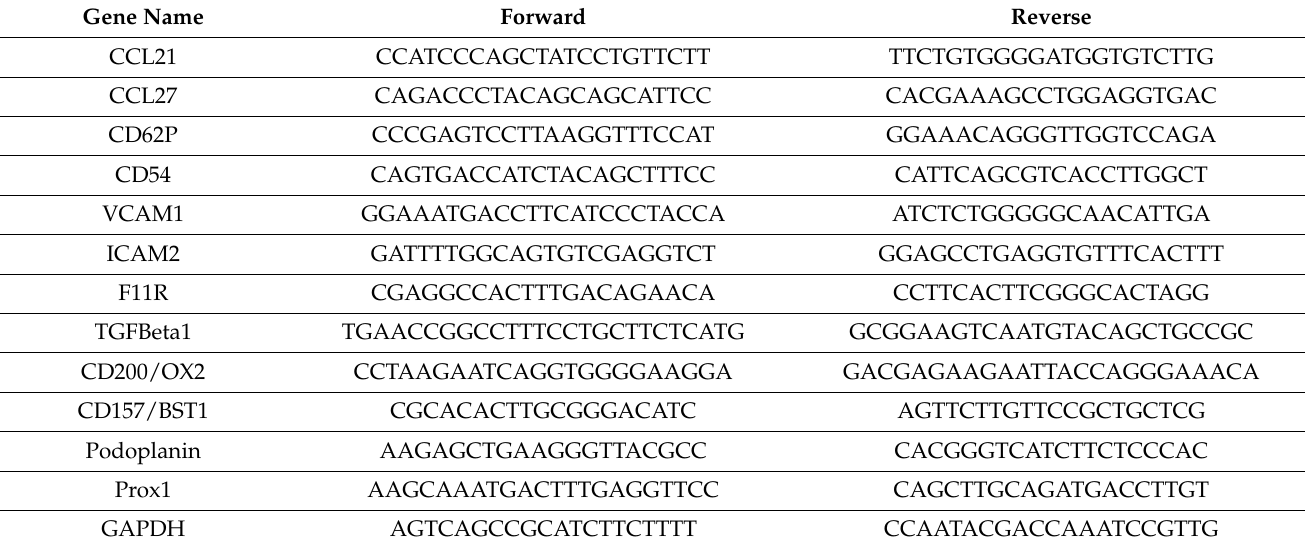
Table 3. Primers used in qRT-PCR